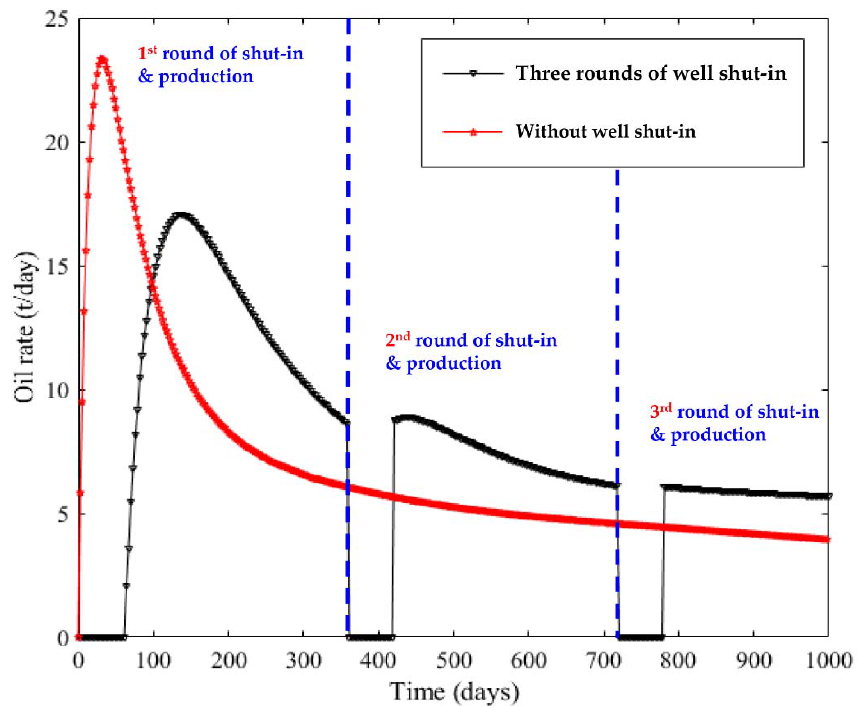
Figure 14. Daily oil rate with three rounds of well shut ‐ in operations.